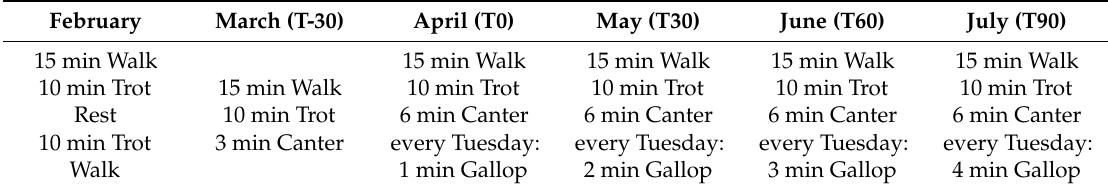
Table 1. Standard daily training program completed by each horse involved in the study. Speeds: